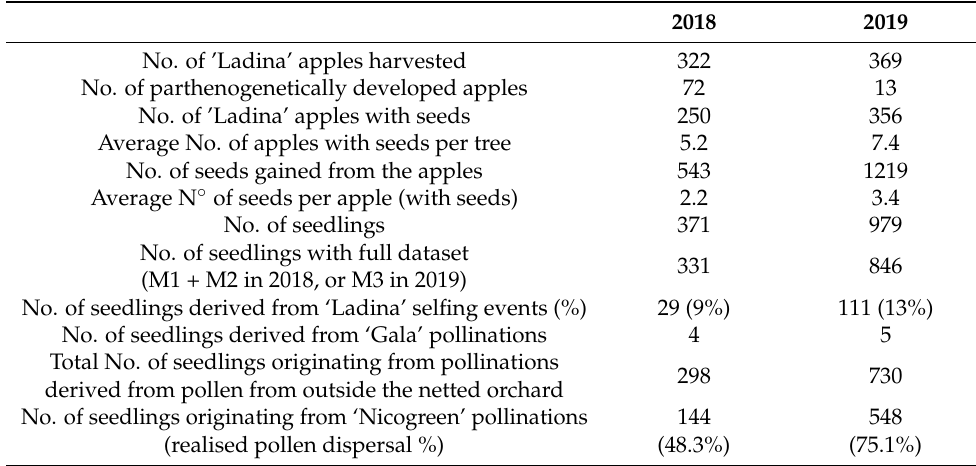
Table 5. Quantification of ‘Ladina’ seedlings originating from ‘Nicogreen’ pollinations in 2018 and 2019. The ‘Ladina’ trees are inside Block 0, the ‘Nicogreen’ trees are